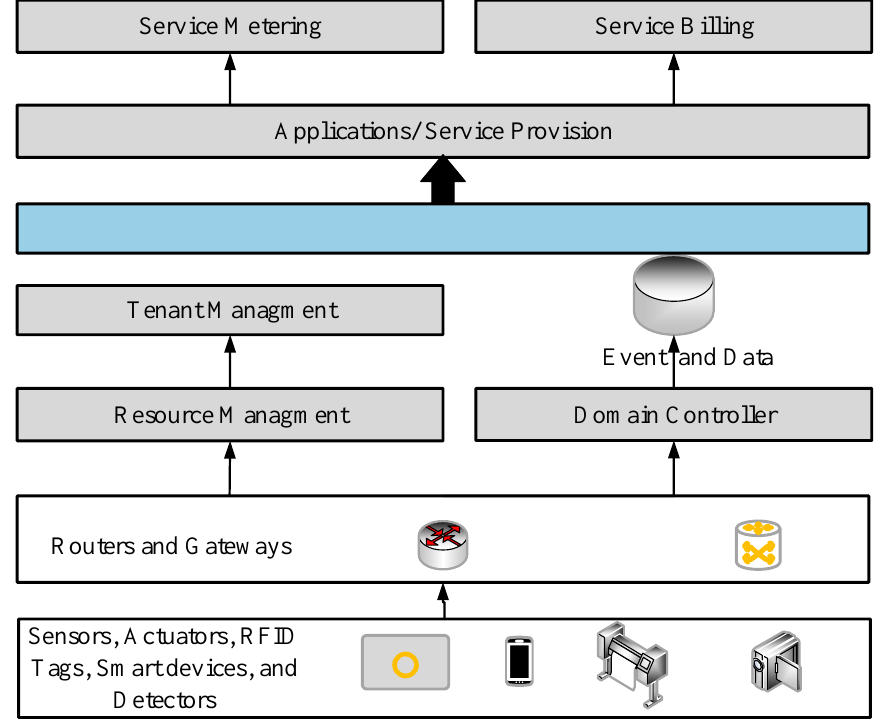
Figure 5. IoT PaaS